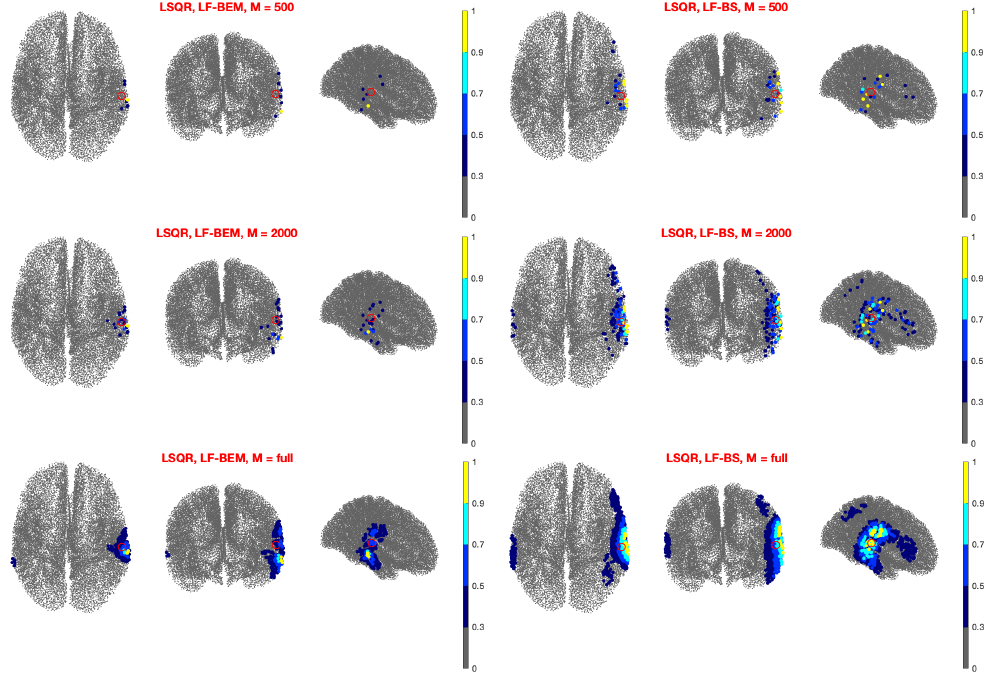
Figure 6. Left Auditory evoked field: The intensity of the estimated sources, averaged over N = 10 runs, at 90 ms obtained using LSQR with M = 500 random points (first row), M = 2000 (second row) and the full source space (third row) for LF-BEM (left column) and LF-BS (right column). The red circle represents the dipole fitted using MNE.